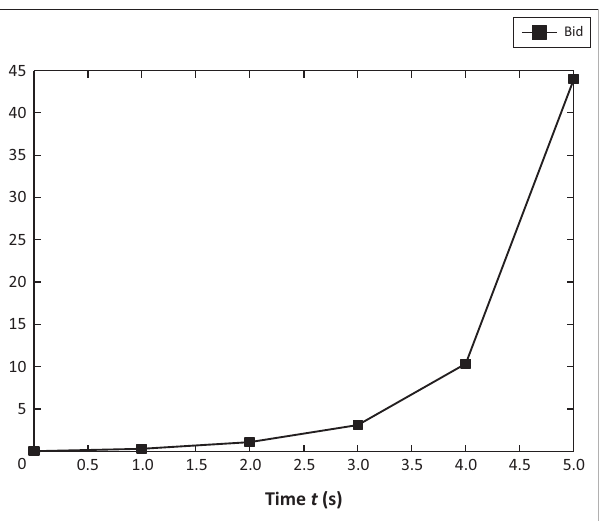
FIGURE 6: Plot of B